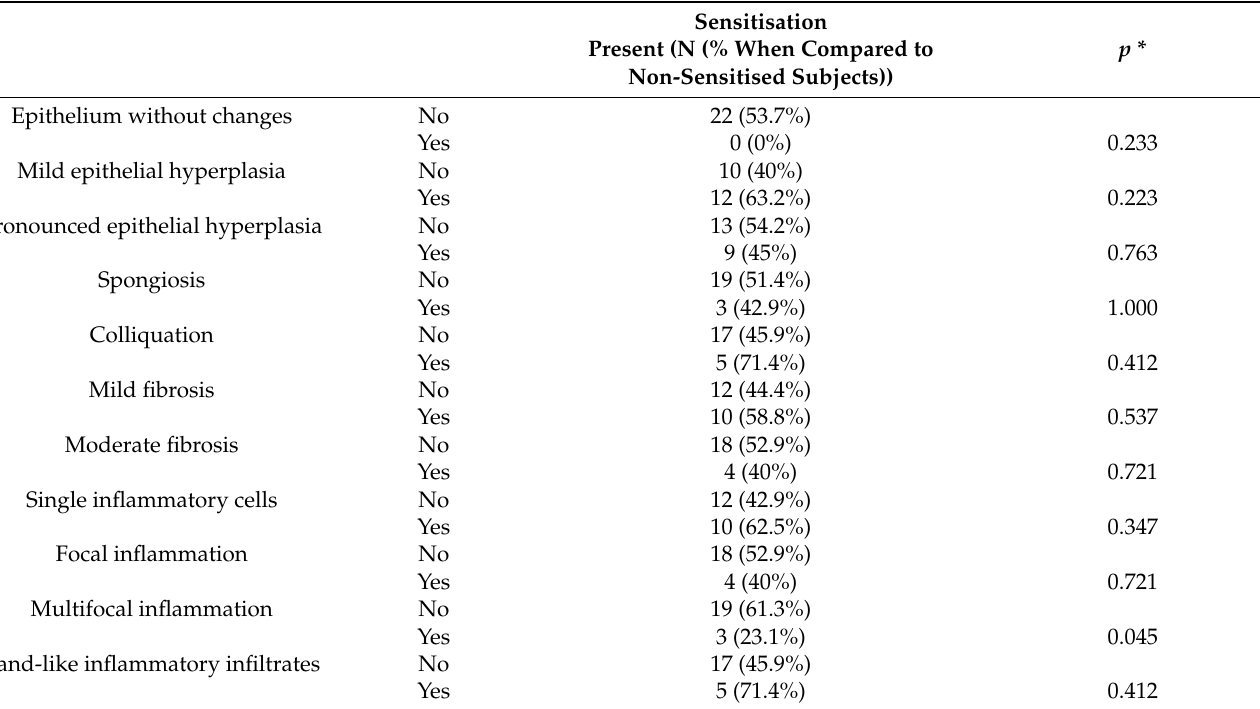
Table 2. Comparison of epithelial histopathological findings and grouping of inflammatory gingival cells of sensitised when compared to non-sensitised subjects.